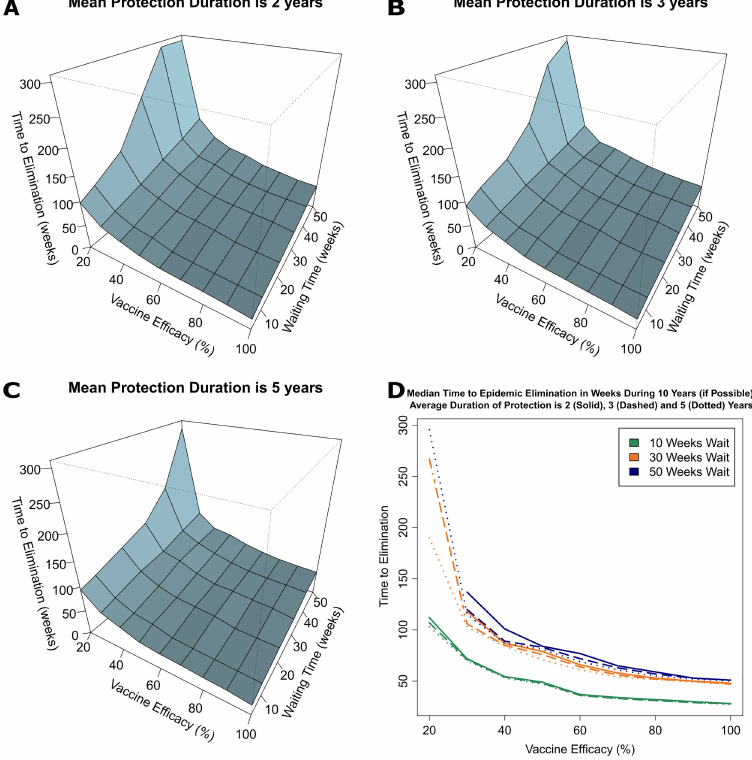
Fig 5. The mediantimes to elimination of cholera transmission for parameter settings definedas combinations of vaccine efficacy (20-100%with 10% increments) and the averagewaitingtime to be vaccinated (5, 10, 20, 30, 40 and 50 weeks) are presented, stratified by the averagedurationof immunity after vaccination of 2 (A), 3 (B), and 5 (C) years. Panel (D) shows slices of the three-dimensional plots at 10, 30, and 50 weeks for the averagewaitingtime to be vaccinated.Times to elimination exceeding300 weeks are truncatedat 300 in panels(A)-(C) and not includedin panel